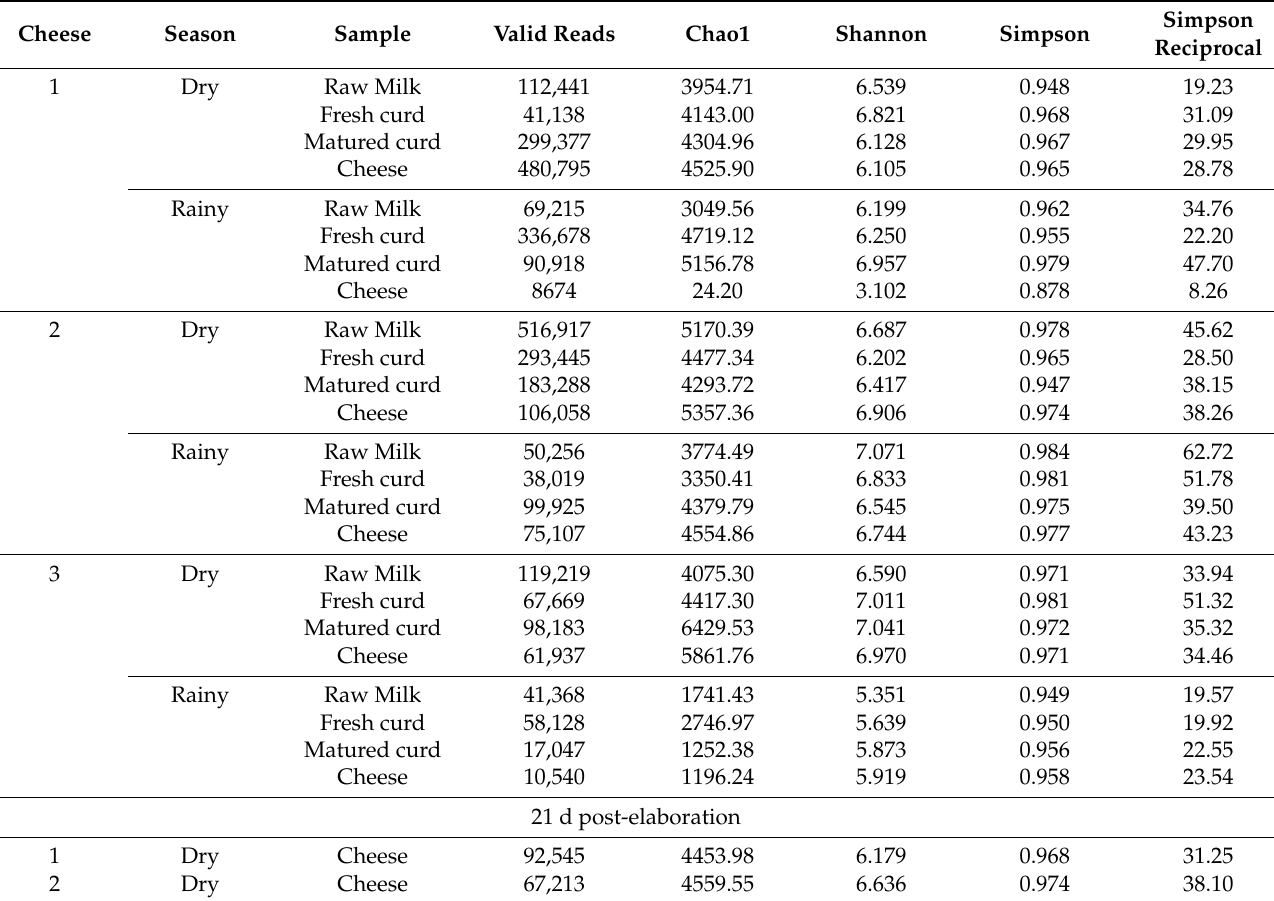
Table 1. Number of sequences and diversity estimators for Adobera cheese